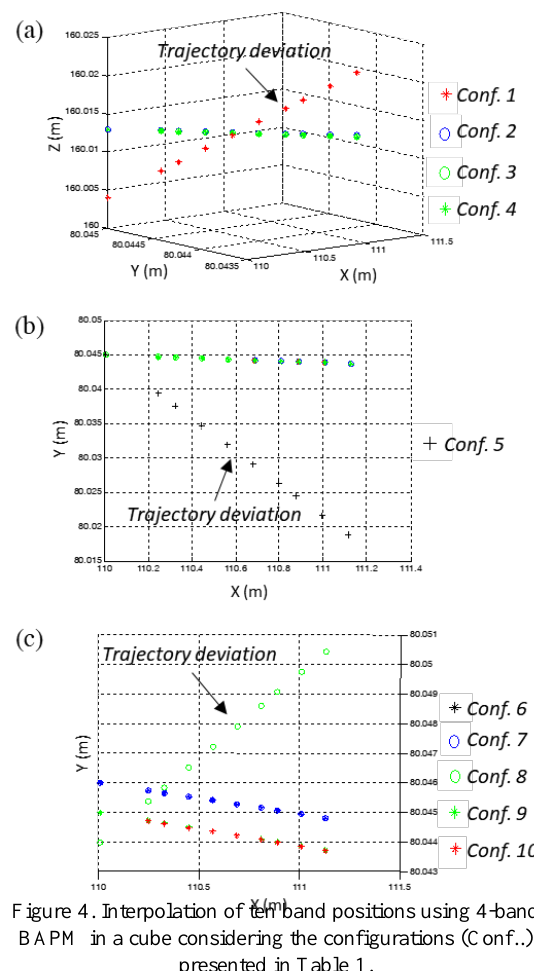
Figure 5. Estimation of ten band positions in a cube considering the configurations (Conf.) presented in Tables 2 and 3.